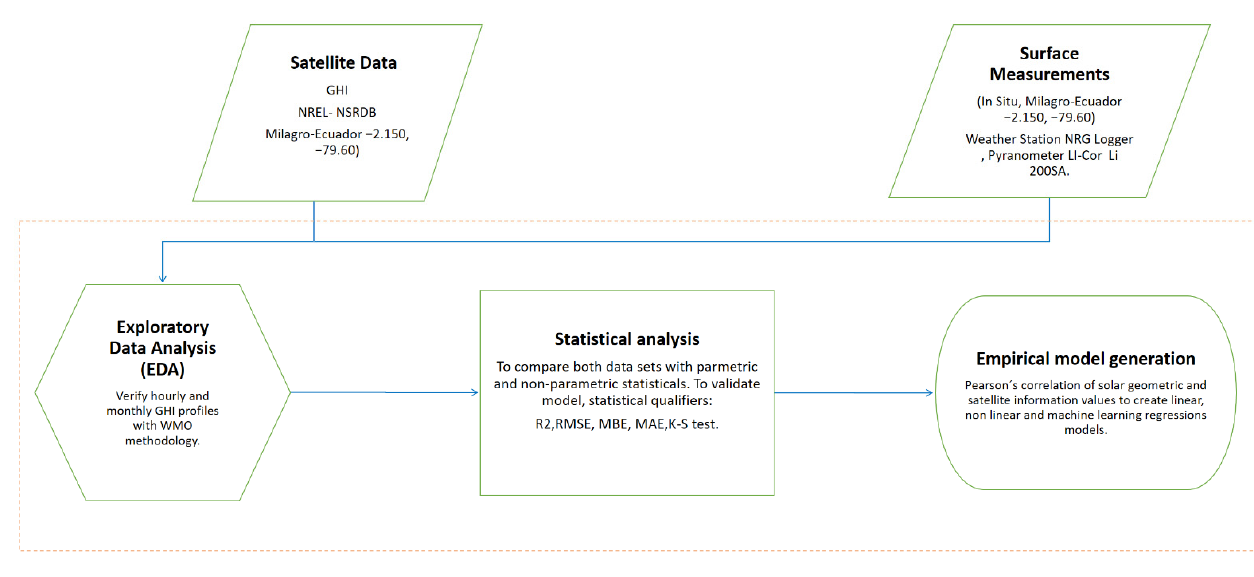
Figure 1. Methodology, the general scheme .